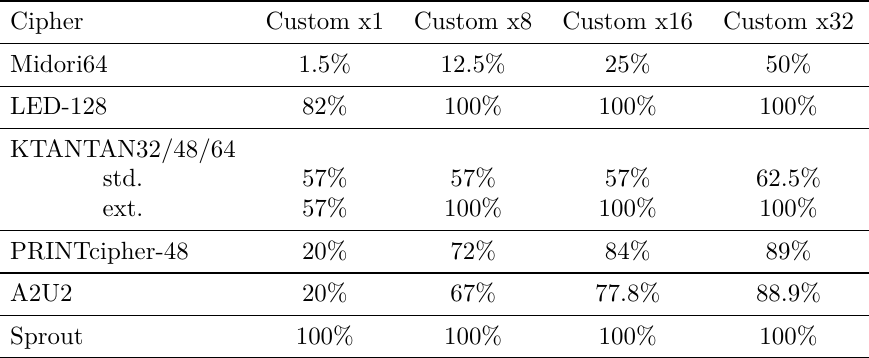
Table 3: Impact of different ASIC EEPROM realizations on the throughput for several ciphers relative to the original throughput, i. e., higher is